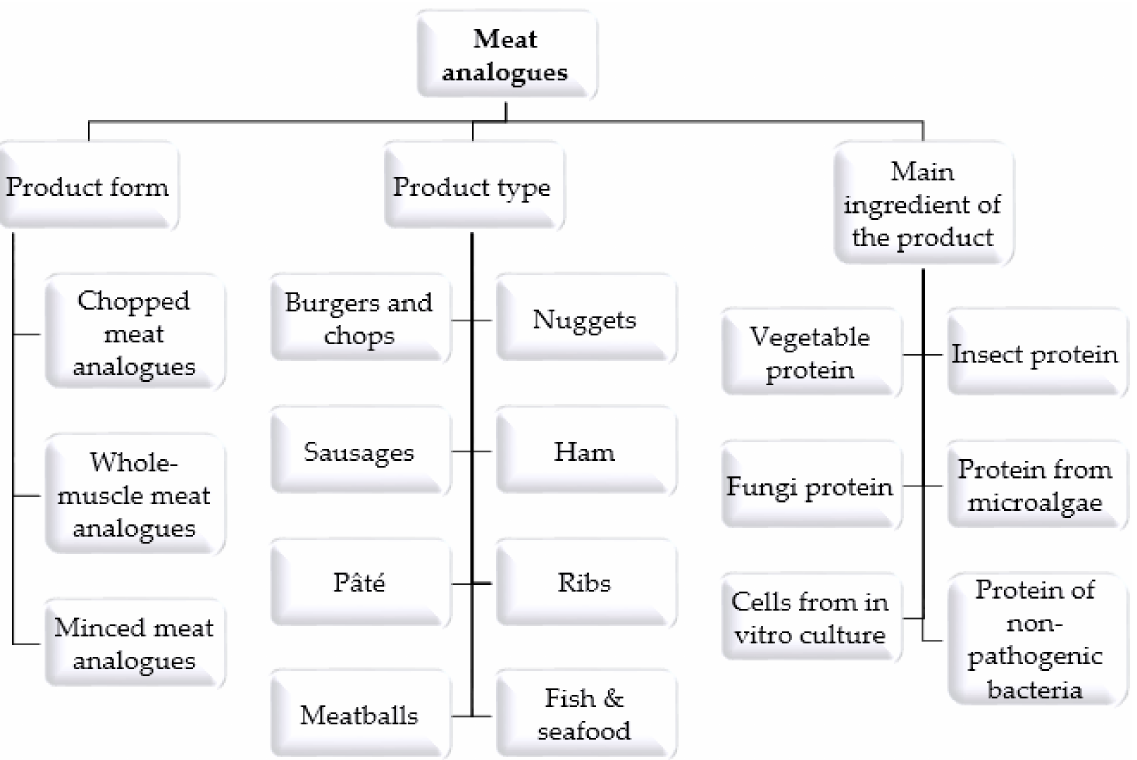
Figure 1. Types of meat analogues available on the